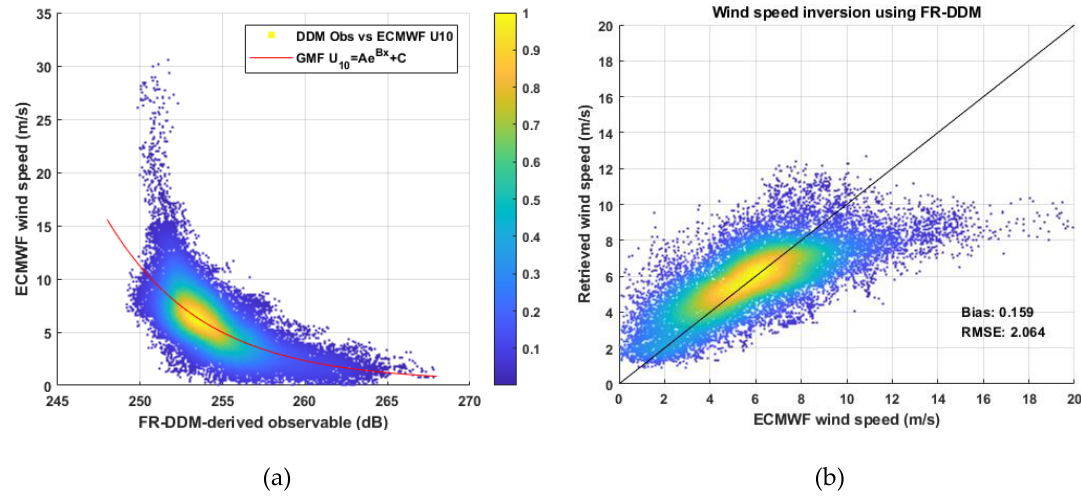
Figure 6. ( a ) CYGNSS FR-DDM-derived σ 0 versus collocated ECMWF wind speed for the training data set with the fitted geophysical model function (GMF) (in red) of the form U 10 = Ae Bx + C ; ( b ) CYGNSS FR-DDM retrieved wind speed with the fitted GMF versus collocated ECMWF wind speed for the test data set.